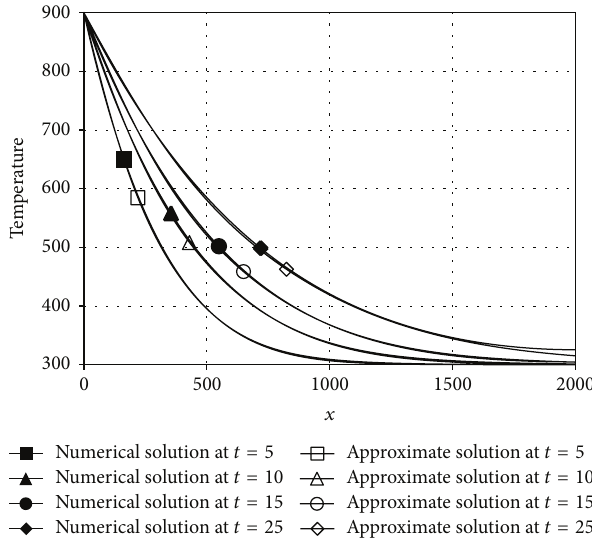
Approximate solution at t = 5 Numerical solution at t = 5 Approximate solution at t = 10 Numerical solution at t = 10 Approximate solution at t = 15 Numerical solution at t = 15 Approximate solution at t = 25 Numerical solution at t = 25 Figure 13: Comparison of approximate analytic solution 𝑇(𝑥,𝑡) and numerical solution of IBVP (42) and (43) at different